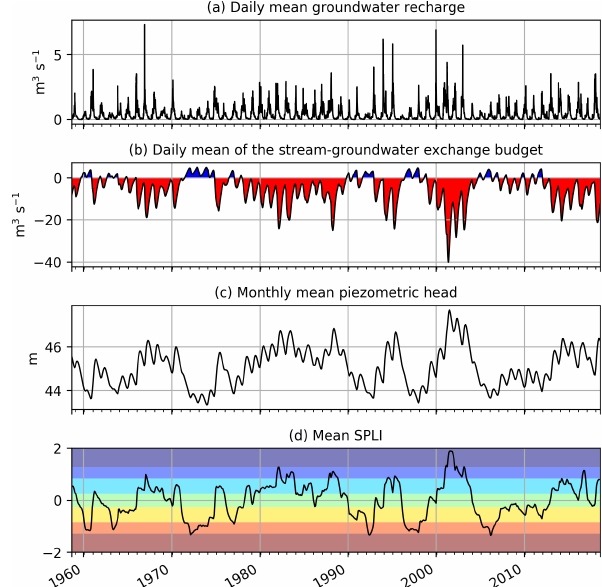
Figure 14. (a) Spatial distribution of E f calculated between the ob- served and simulated karstic spring flows and river flows for the gauging stations monitoring the 23 simulated karstic systems (stars) and the 362 selected gauging stations located in the distributed hy- drogeological models (circles). Cumulative distribution of E f for (a) the 23 karstic systems and (b) the 362 gauging stations of the distributed models are also shown. E f for karstic systems are com- puted using the square root of the daily karstic spring flows. The simulated river network is shown in the background.